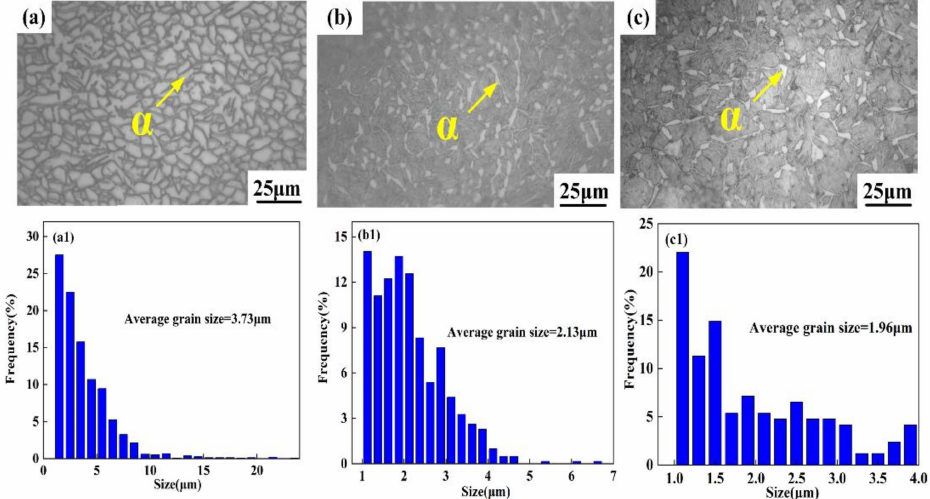
Figure 5. OM micrographs and grain size distribution histograms of Zr-4Hf-3Nb (wt%) alloy with various cooling rate: ( a , a1 ) FC-1, ( b , b1 ) AC, ( c , c1 )